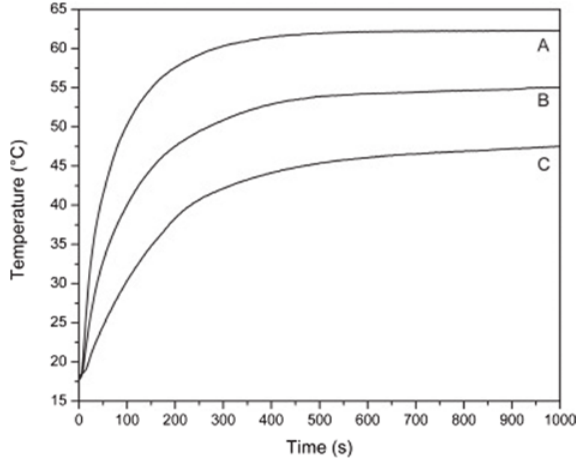
Figure 11: The calorimetric measurements of samples A, B, and C at a magnetic field of 29.4 kA/m and a frequency of 100 kHz. Reproduced with permission from Elsevier: Journal of Alloys and Compounds